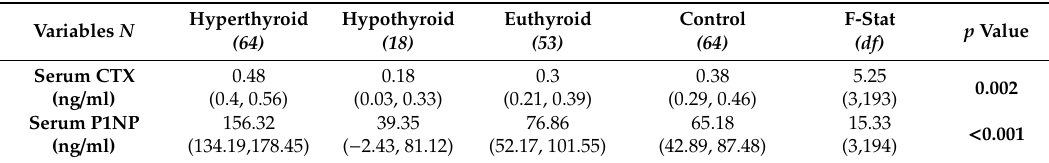
Table 9. ANCOVA analysis adjusted for age and gender. Comparison between mean serum CTX and serum P1NP in between groups.